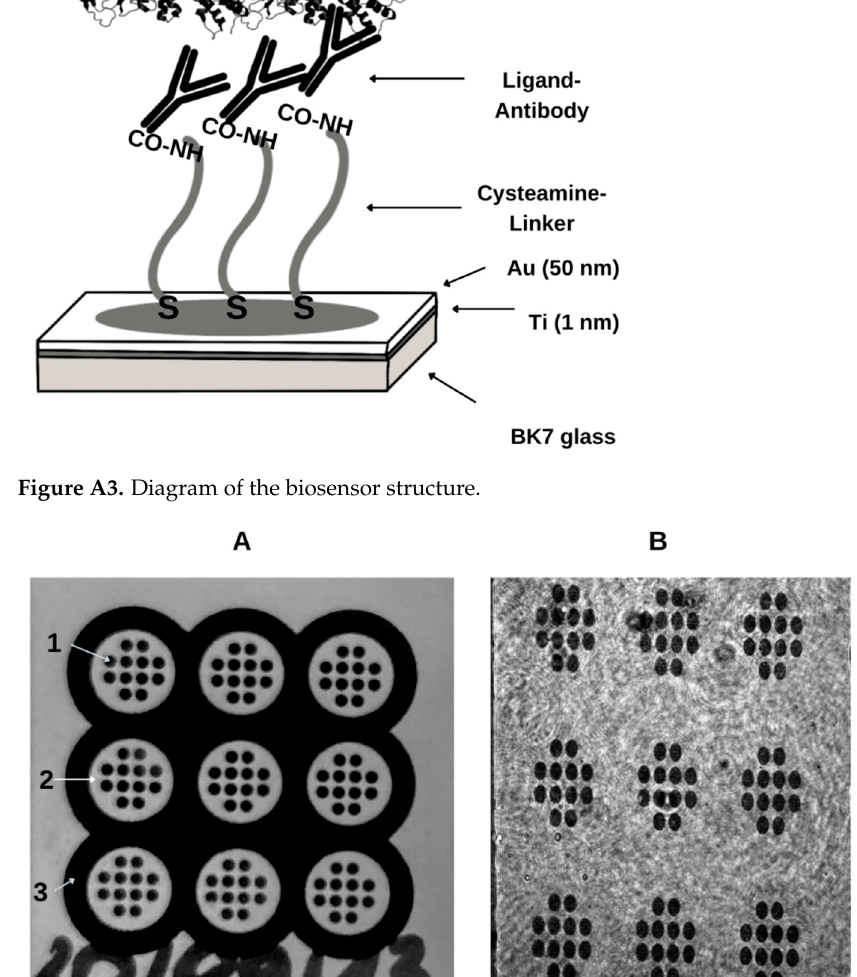
Figure A4. ( A )–diagram of the chip (1–photopolymer, 2–gold surface, 3–hydrophobic paint); ( B )–SPR image of the chip obtained using a CCD camera.